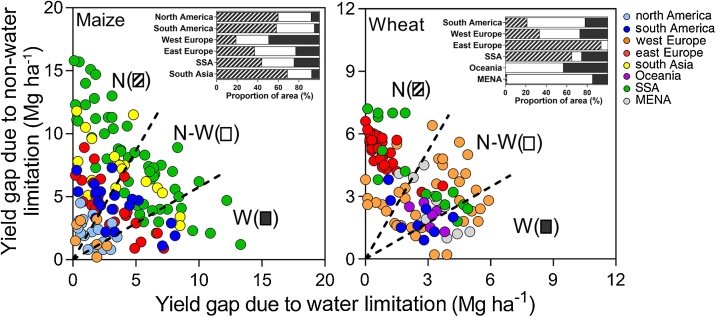
Yield gap due to non-water versus water limitating factors for maize and wheat in each climate zone (CZ). The yield gap due to water limitation was calculated as the difference between yield potential (Yp) and water-limited yield potential (Yw), while the yield gap due to non-water limitation was calculated as the difference between Yw and actual on-farm yield (Ya). Lines separate CZ where yields are predominantly limited by water (W), non-water related factors (N), or similarly limited by both (N-W). Insets show the fraction of cropland area within each target region that falls in each (N, N-W, W) category.